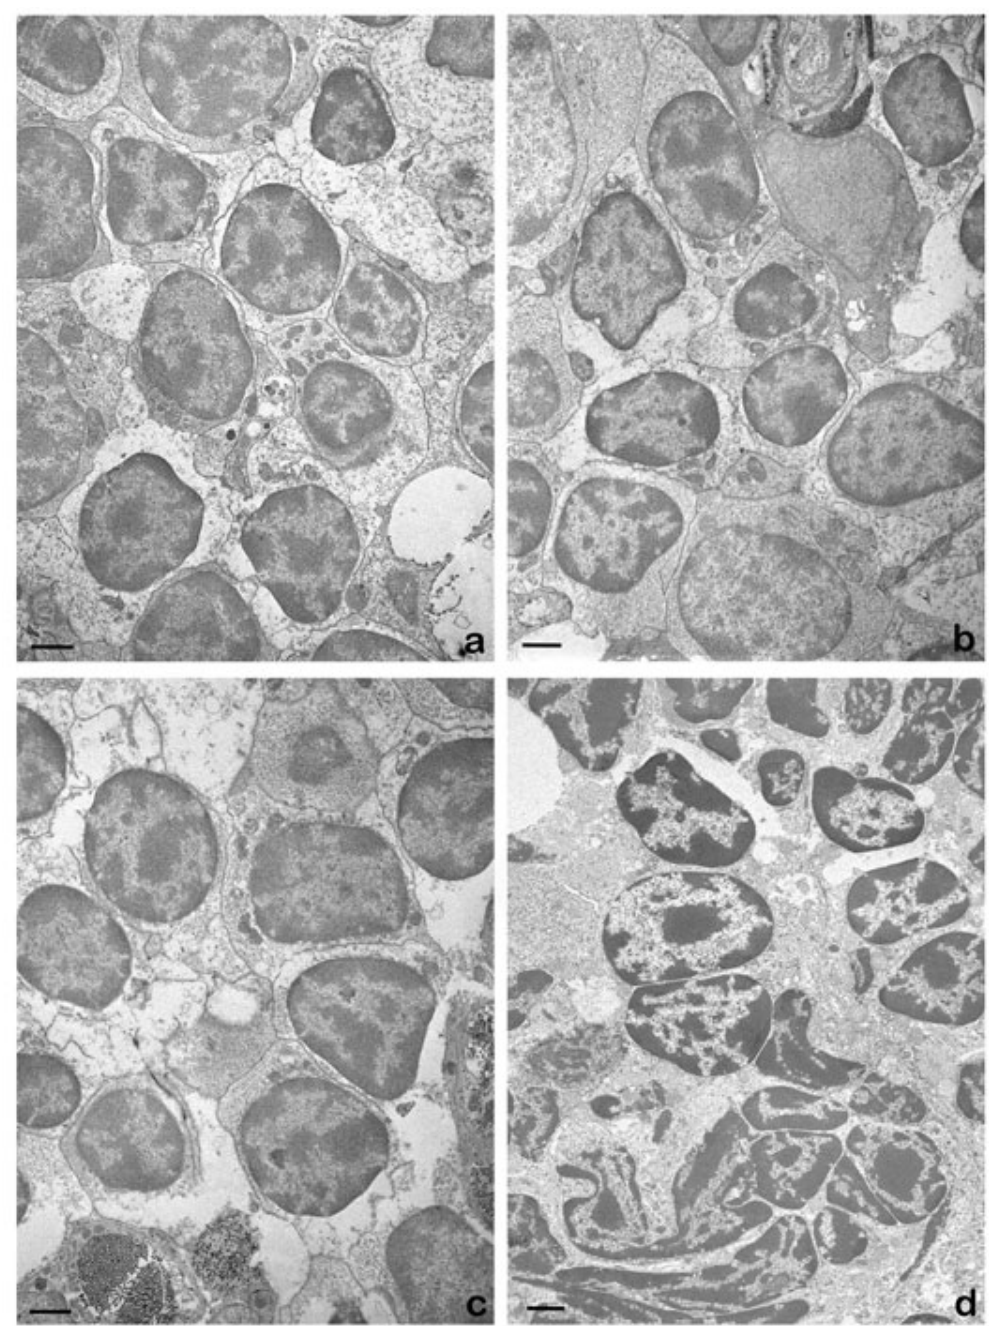
FIGURE 4 . Electron microscopy of thymus from 10-month-old rats exposed for 8 months to CL (a) and to 50-Hz sinusoidal EMF at two levels of field intensity (b, 1 kV/m, 5 µ T and c,d, 5 kV/m, 100 µ T). Necrosis and clustered cell death are clearly responsible for the dramatic reduction of cell-cell adhesion in animals exposed under CL to EMF. Bar: 1 µ m.